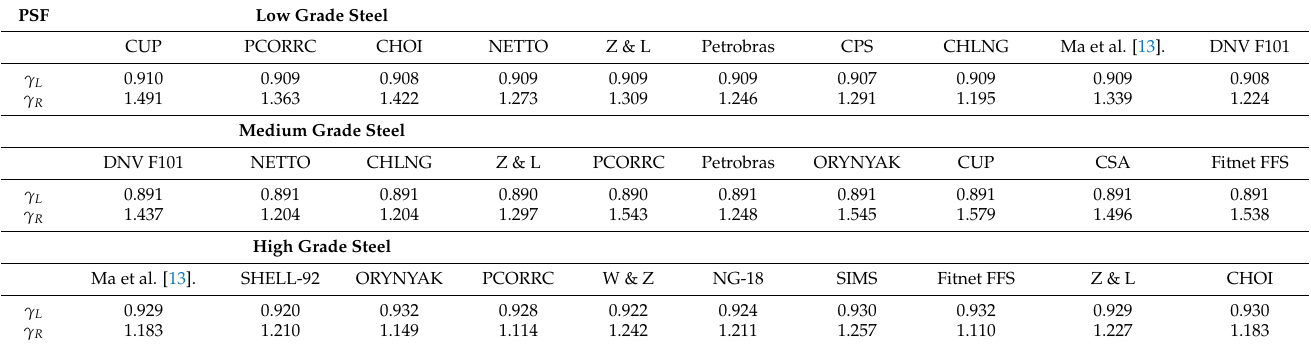
Table 5. PSFs of intact pipes of low, medium and high steel grades.